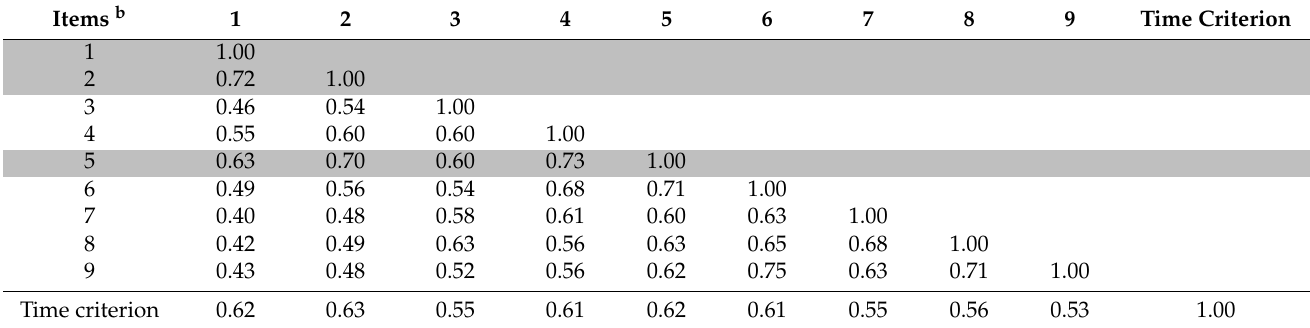
Table 3. Inter-item Pearson correlation of STREDIS-P items a .